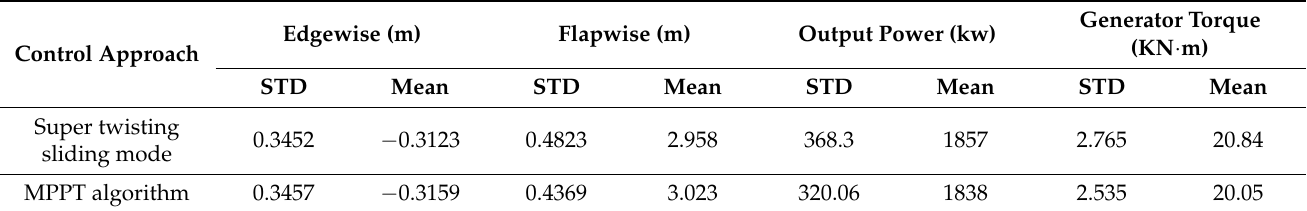
Figure 15. A comparison between the performance of the classical MPPT control approach (ISC) and Super twisting sliding mode control. ( a ) Flapwise tip deflection of blade 1. ( b ) Output power. ( c ) Edgewise tip deflection of blade 1. ( d ) Rotor speed of both approaches and the optimal value. Table 3. Detailed simulation with mean wind speed 8 m/s and turbulence intensity 10%.